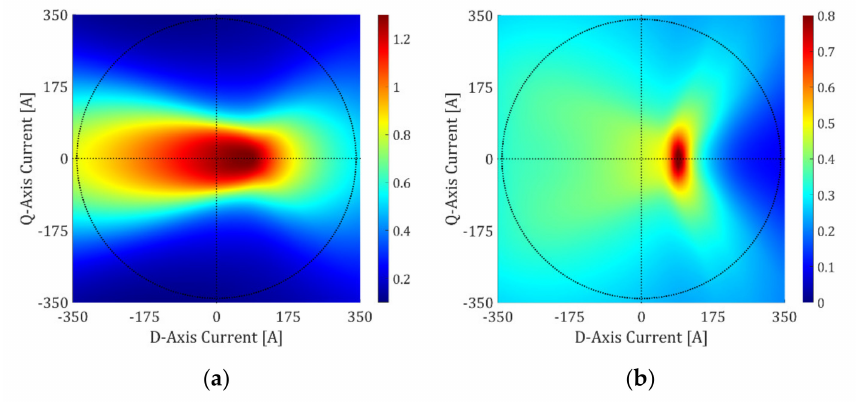
Figure 6. Inductance maps of the electric machine: ( a ) d-axis ( b ) q-axis.